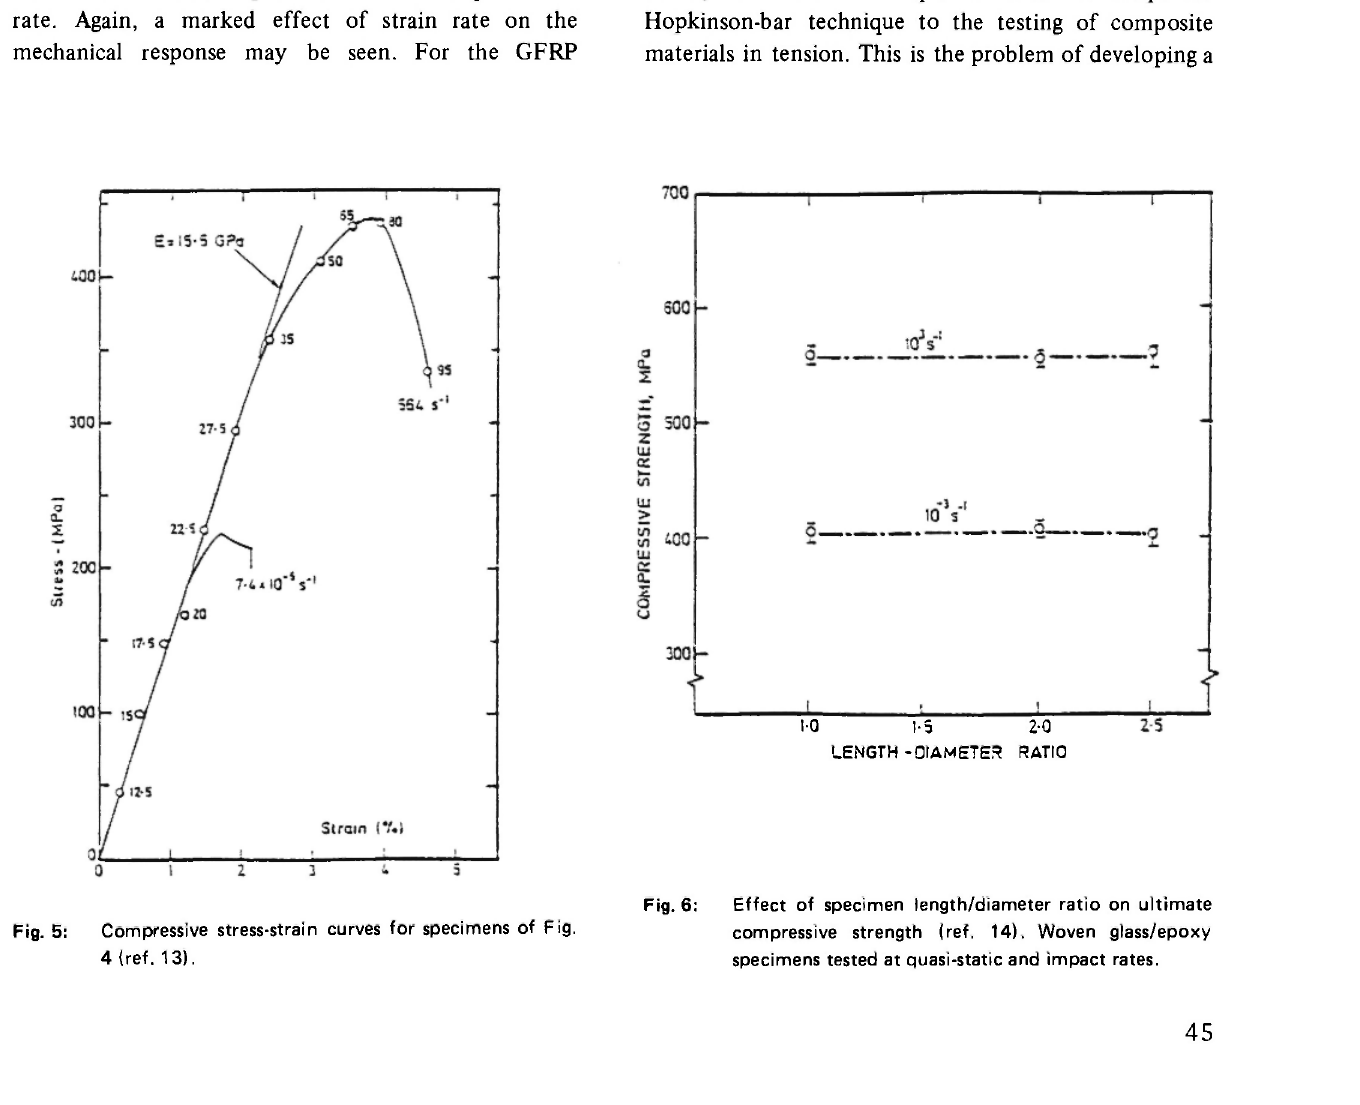
Fig. 6: Effect of specimen length/diameter ratio on ultimate compressive strength (ref. 14). Woven glass/epoxy specimens tested at quasi-static and impact